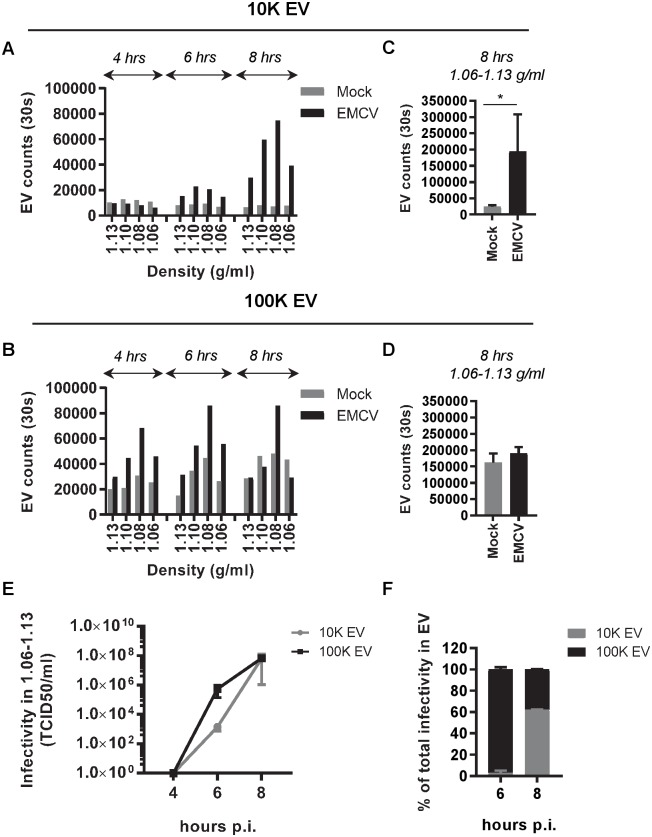
10K and 100K virus-containing EV are released by EMCV-infected cells at different time points after infection.(A-D): EV were fluorescently labeled with PKH67 and quantified by high-resolution flow cytometry. EV numbers were compared for virus-infected and mock-infected cells at 4, 6, and 8 hours after infection. Indicated are the number of EV acquired in a fixed time window of 30 seconds. (A,B): Bar graphs display the number of 10K (A) and 100K (B) EV in individual EV-containing density fractions at 4, 6, or 8 hrs p.i. Data are representative for N = 2 (10K EV (A)) and N = 3 (100K EV (B)) independent experiments. (C,D): Total numbers of 10K EV (C) and 100K EV (D) in density fractions (1.06–1.13 g/ml) released during 8 hrs of culture in Mock versus EMCV infected conditions (mean ± s.d. of N = 4 independent experiments, * p<0.05). (E) The infectivity in 10K and 100K EV fractions (1.06–1.13 g/ml) was assessed by end-point dilution at 4, 6 and 8 hours p.i. Indicated are mean values ± s.d. for N = 3 experiments. (F) The contribution of infectivity in 10K and 100K EV to total infectivity in EV was calculated at 6 and 8 hours p.i. Indicated are mean values and range of N = 2 independent experiments.